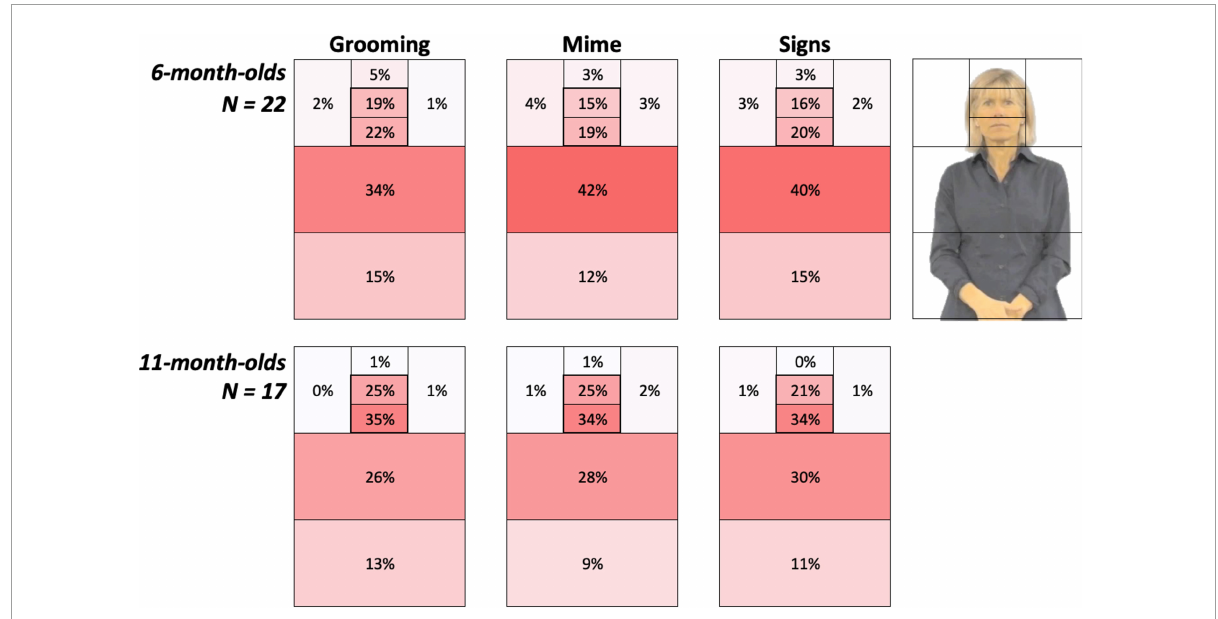
FIGURE3 Heat Grids for each age group and Body Action type conditions. These results show the average percent looking time for each AOI, separately for 6-month-olds ( top ) and 11-month-olds ( bottom ). Color scaling per cell refers to a gradient from the highest (red) to the lowest (white) percent looking values. The outline in the upper right corner represents the AOI locations on the signer. Each grid, including the Left and Right side of AOIs, sums to 100%. As discussed in the Results, 6-month-olds were more drawn to the articulatory space while 11-month-old infants spent 19–25% more time attending to the